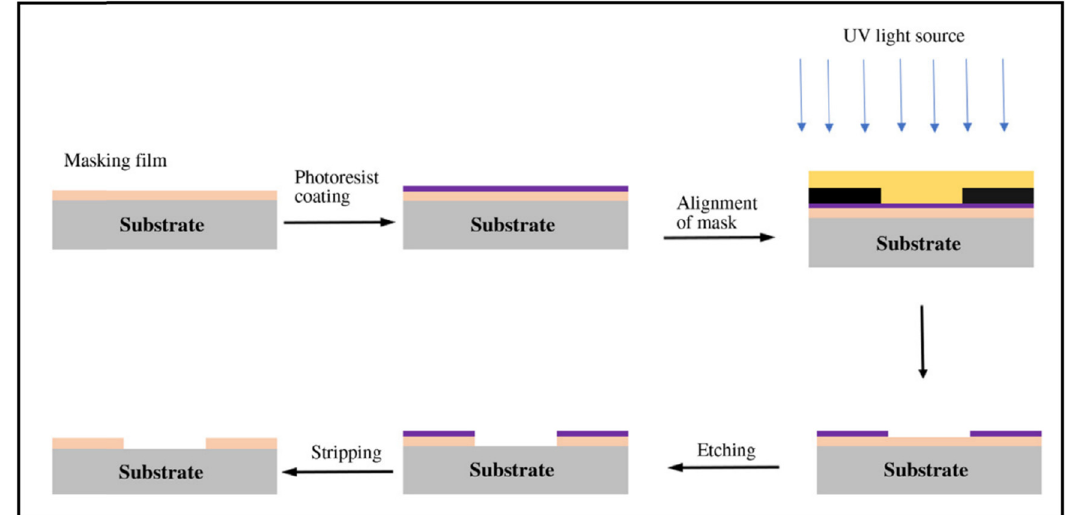
Figure 14: Schematic illustration of photolithography [ 111 ] . Copyright 2019, Elsevier ™